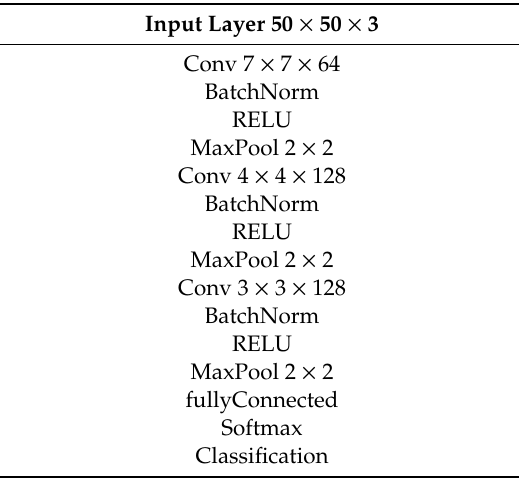
Table A1. CNN algorithm